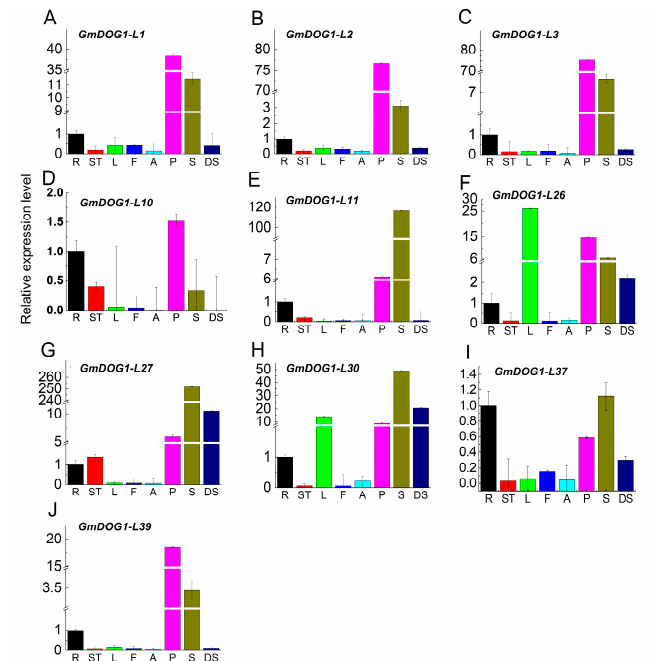
Figure 3. Expression profiles of GmDOG1Ls in different tissues ( A – J ). Expression levels of 10 selected GmDOG1Ls were examined by qRT-PCR analysis. The housekeeping gene GmTubulin was used as an endogenous reference gene. Roots (R), stems (ST), leaves (L), flowers (F), apical meristems (A), pods (P), dry seeds (S) and developing seeds (DS) were sampled for qRT-PCR analysis. Error bars represent standard errors.